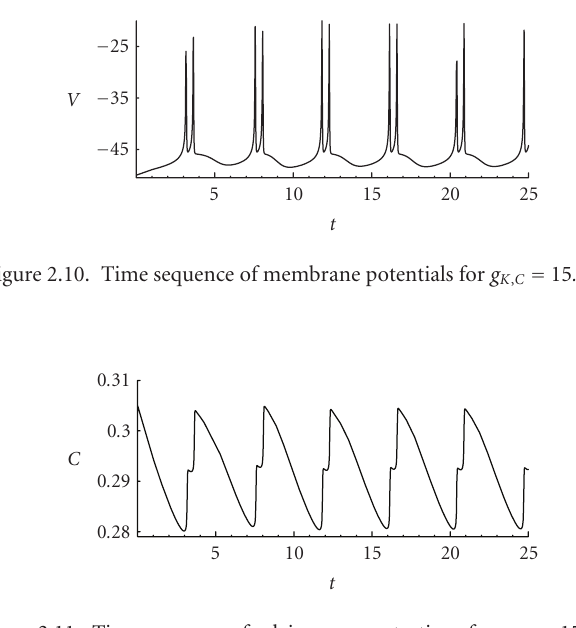
Figure 2.11. Time sequence of calcium concentrations for g K , C = 15 . 2 s − 1